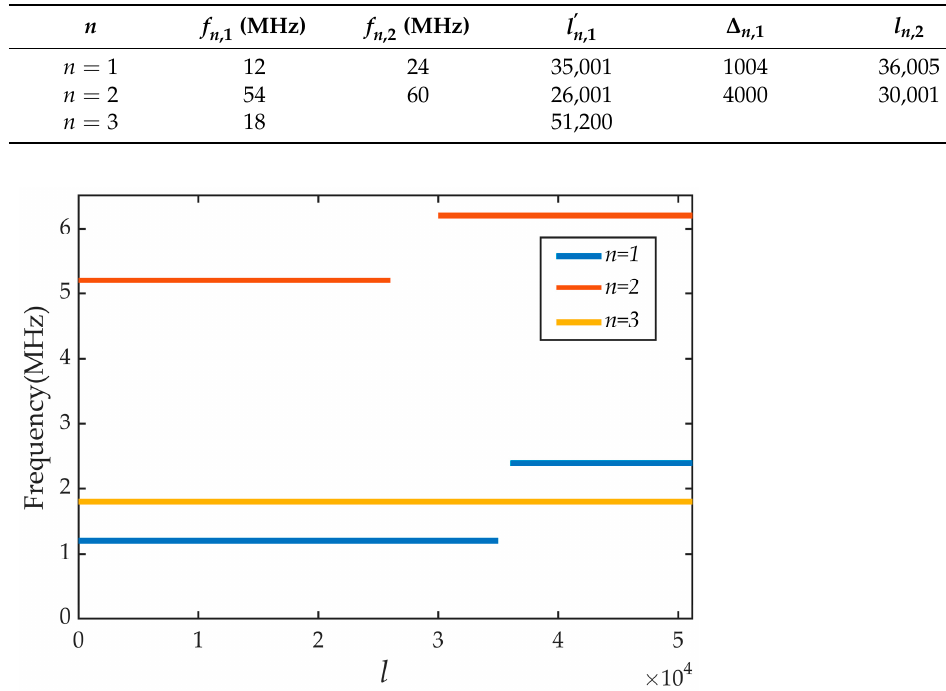
Figure 15. Schematic diagram of multiple FH signals with frequency-switching time.